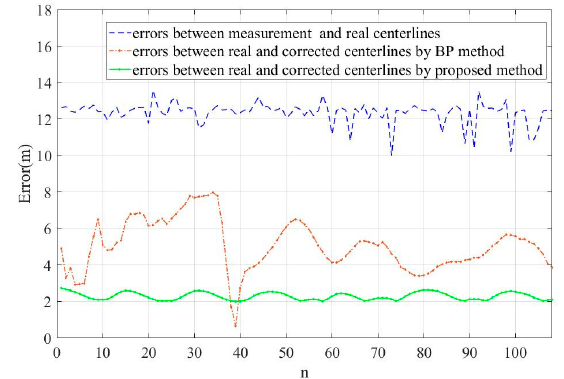
Figure 16. Error results between different algorithms.